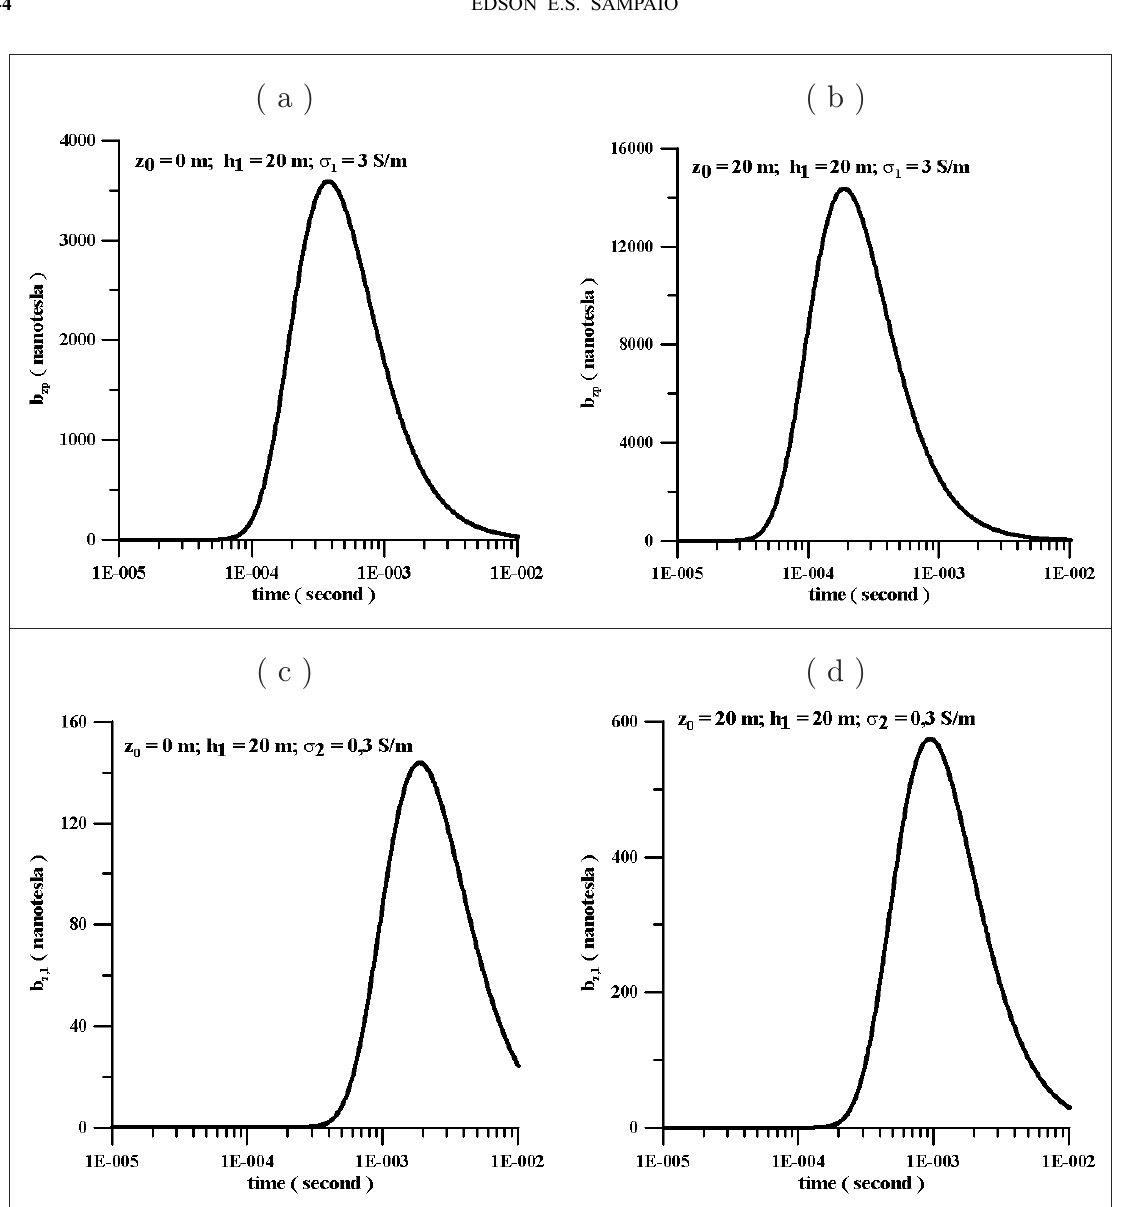
Fig. 3 – Graphs of the time variation of the vertical component of the magnetic field for the case of a water layer with h 1 = 20 m and σ 1 = 3S/m, overlying a basement with σ 2 = 0 . 3S/m. Primary: b zp . Total: b z , 1